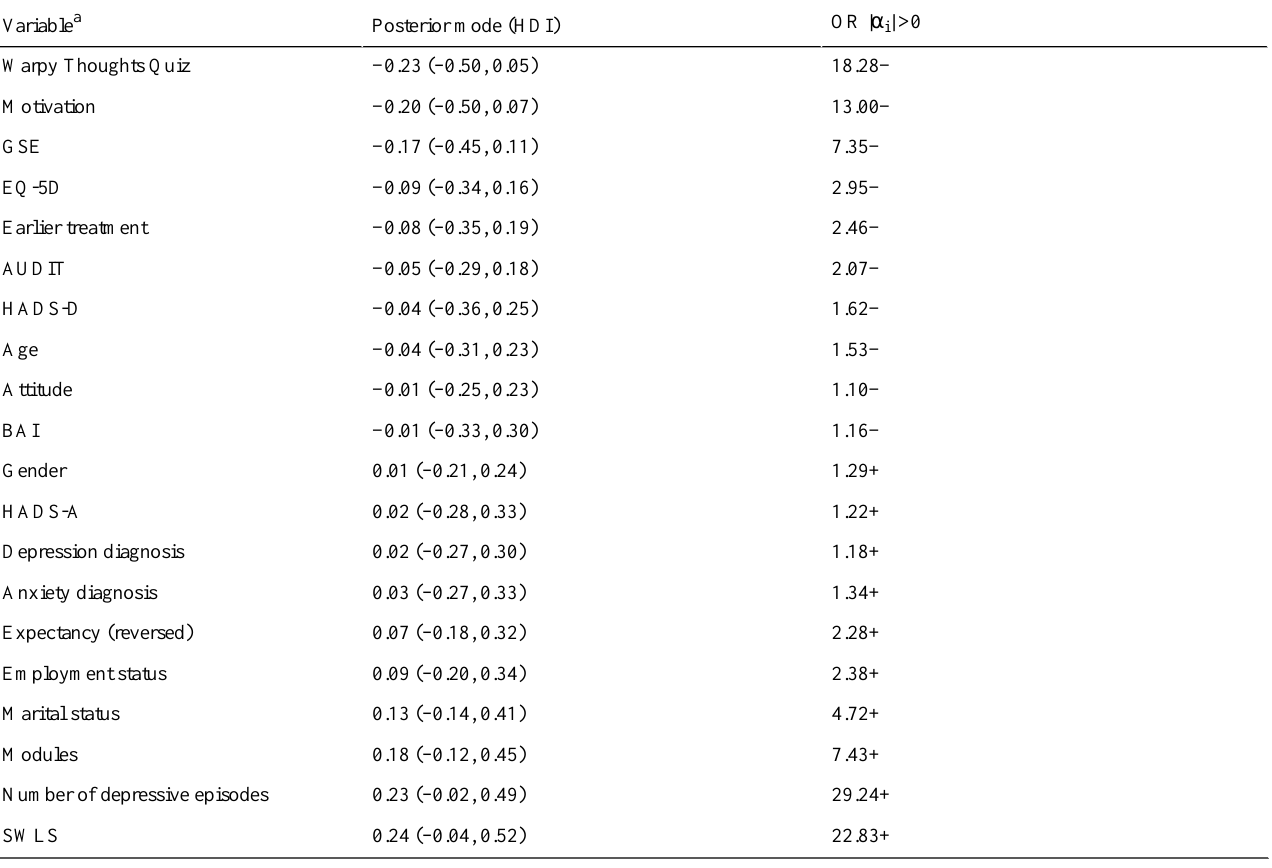
Table 4. Posterior mode, highest density interval (HDI), and odds ratios for the α coefficients predicting the strength of the response. The α coefficients are the group-level regression coefficients on the slope of the treatment effect in the quadratic model (see Equation 5 in Multimedia Appendix 1). The odds ratios indicate the probability that each covariate has a positive/negative impact relative to the probability of the opposite (+: positive effect, –: negative effect), but do not indicate the strength of this